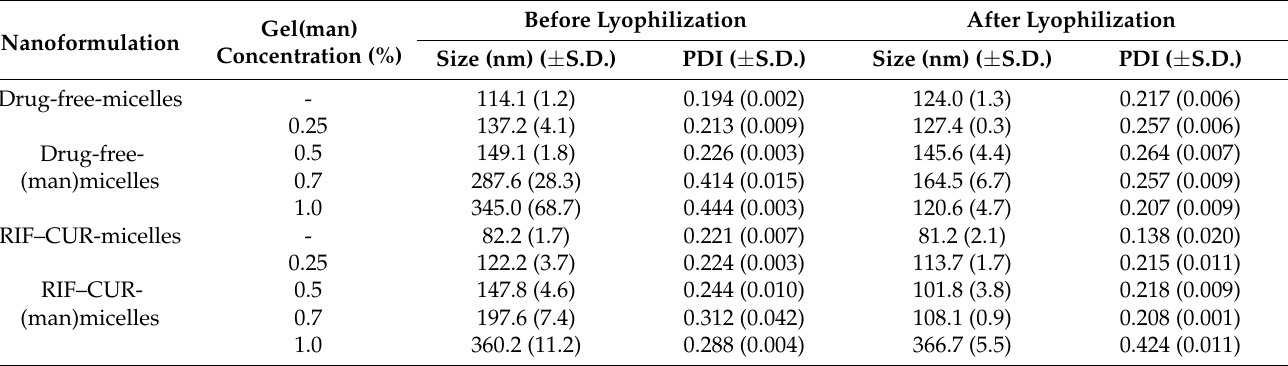
Table 2. Micellar size and size distribution (PDI) of free and drug-loaded Solupus micelles (10% w / v ) with and without mannose at 25 ◦ C, before and after lyophilization. Data are expressed as mean ± S.D. (n =